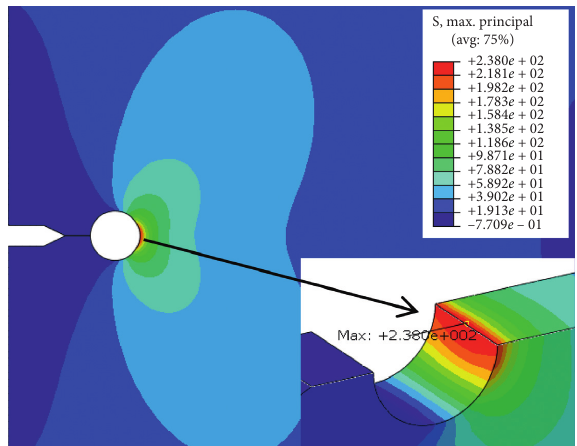
Figure 5: Maximum principal stress distribution.